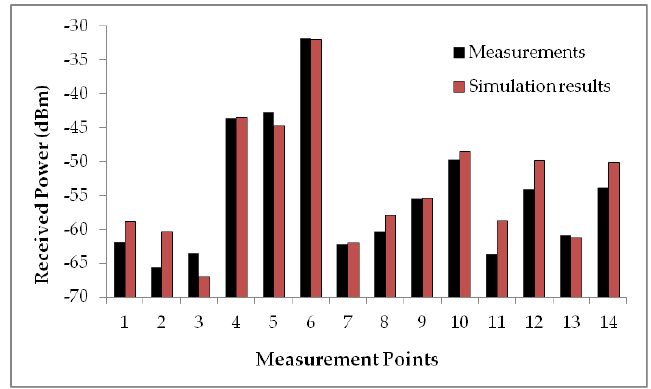
Figure 10. Measurement vs simulation results when the dog is not located inside the room.